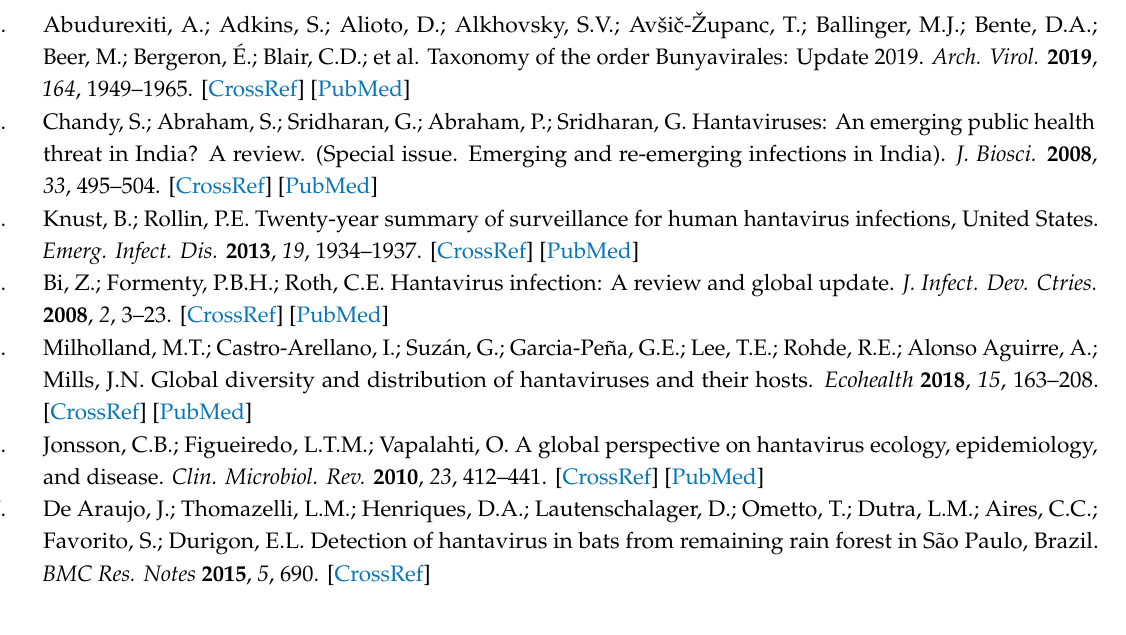
Supplementary S1: North American and South American Assemblage Locality Citations, Table S2: Non-rodent small mammal hosts of Orthohantaviruses (Order: Bunyavirales; Family: Hantaviridae) from